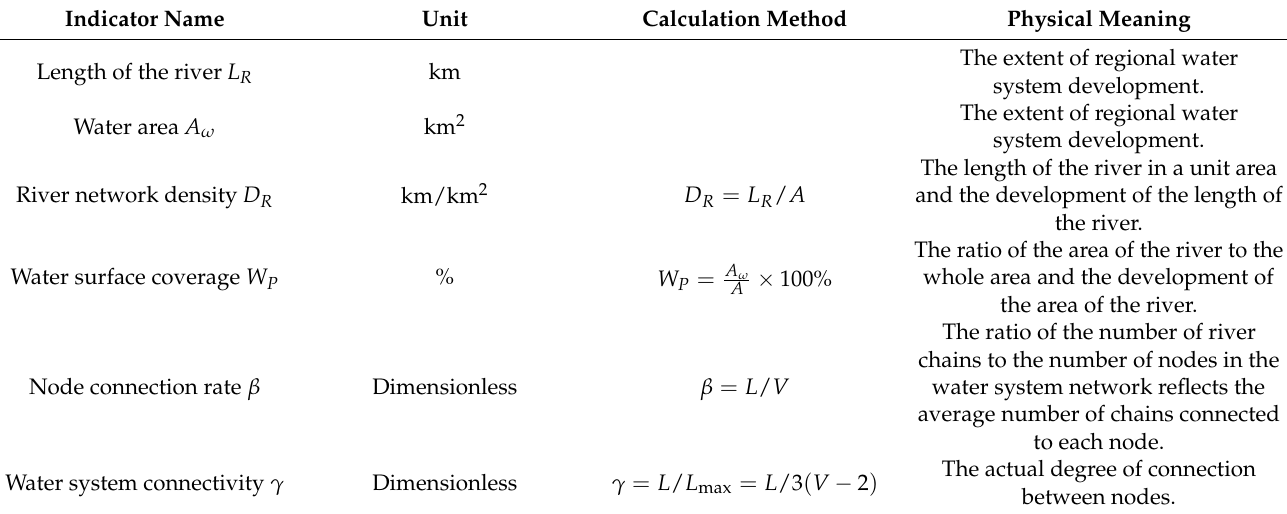
Table 2. Index system of the connected forms of the water